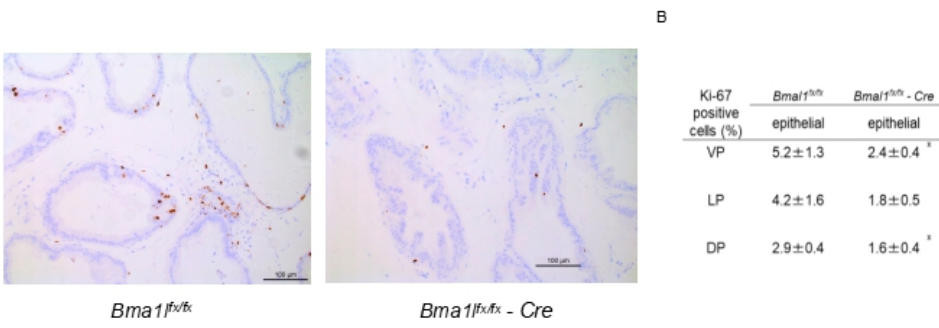
Figure 2. Ki-67 immunostaining of mouse prostates. ( A ) Representative image of 20-week-old mouse prostate (VP). ( B ) Percentage of Ki-67-positive cells; N = 6 each. * p < 0.05 using Student’s t -test.